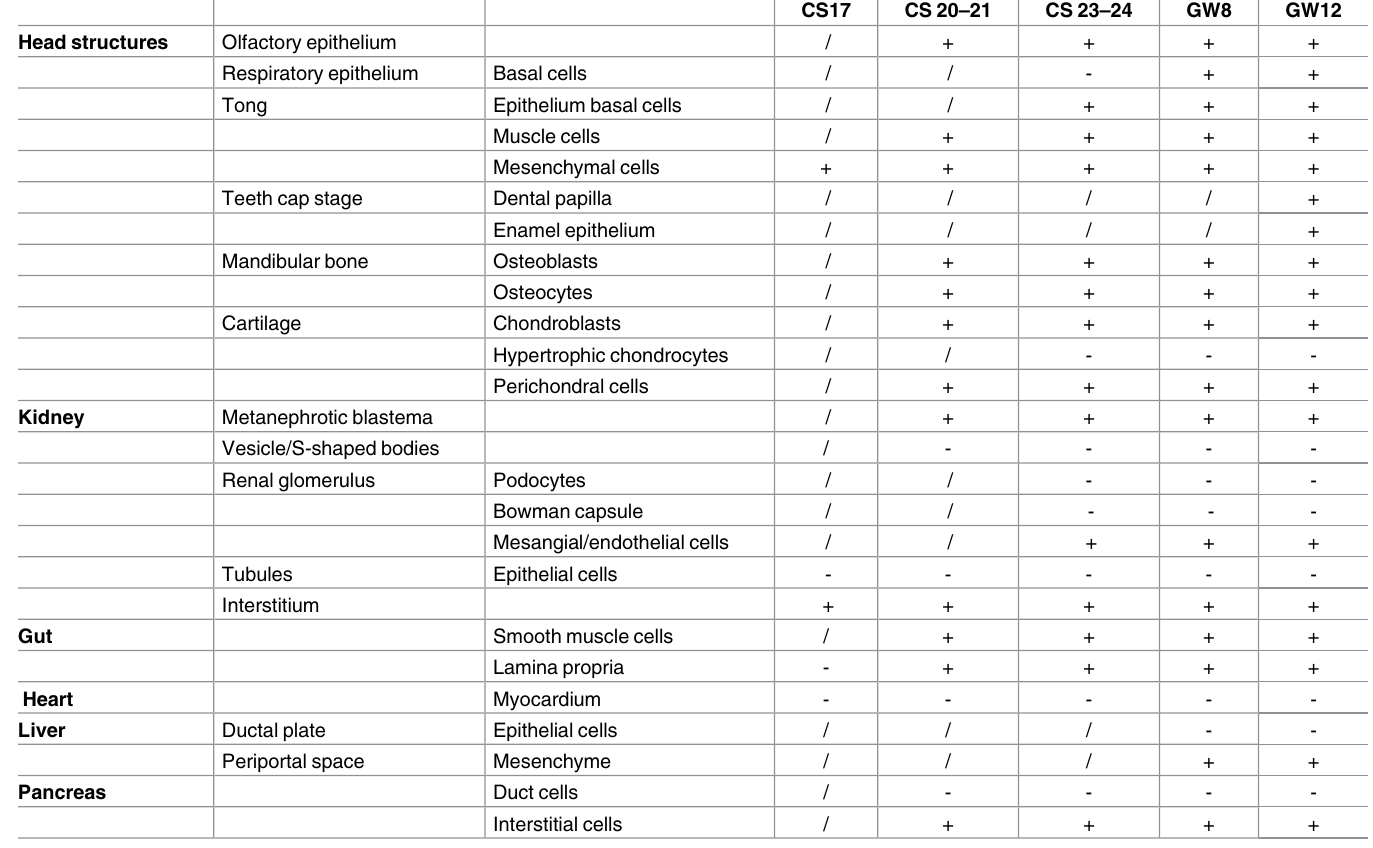
Table 1. AC3 detection in primary cilia of human developing organs. Head structures Olfactory epithelium